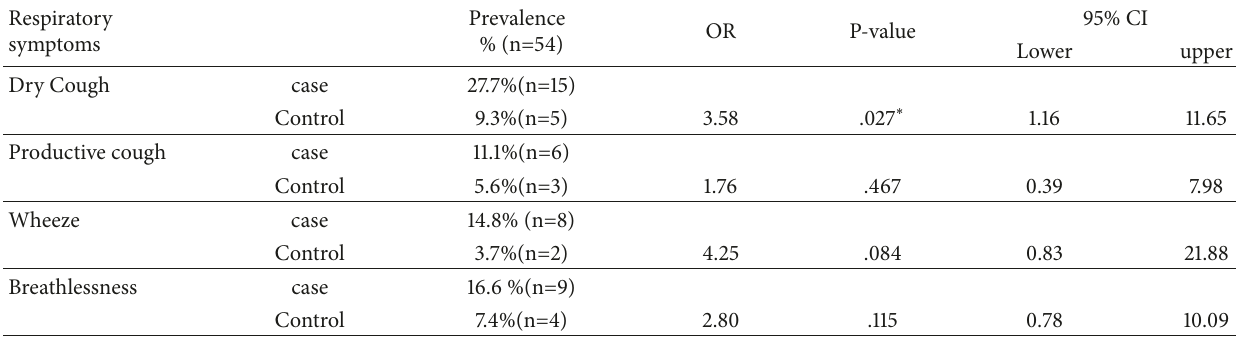
Table 3: Respiratory symptoms of exposed and nonexposed subjects including OR and 95% CI.